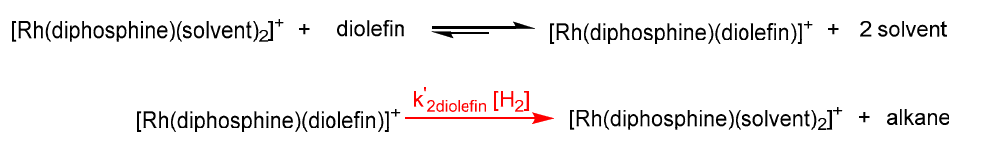
Figure 8. Left: Hydrogen uptake (ml) as a function of time (min) in the hydrogenation of mac with [Rh(( R , R )-Et-ButiPhane)(COD)]BF 4 (99.0% ee, blue) and with [Rh(( R , R )-Et-ButiPhane)(MeOH) 2 ]BF 4 (99.0% ee, green) under standard conditions [92]. Right: moles of hydrogen consumed per unit time (dn/dt) as a function of time (min) in the hydrogenation of mac with [Rh(( R , R )-Et- ButiPhane)(COD)]BF 4 (blue) and [Rh((R,R)-Et-ButiPhane)(MeOH) 2 ]BF 4